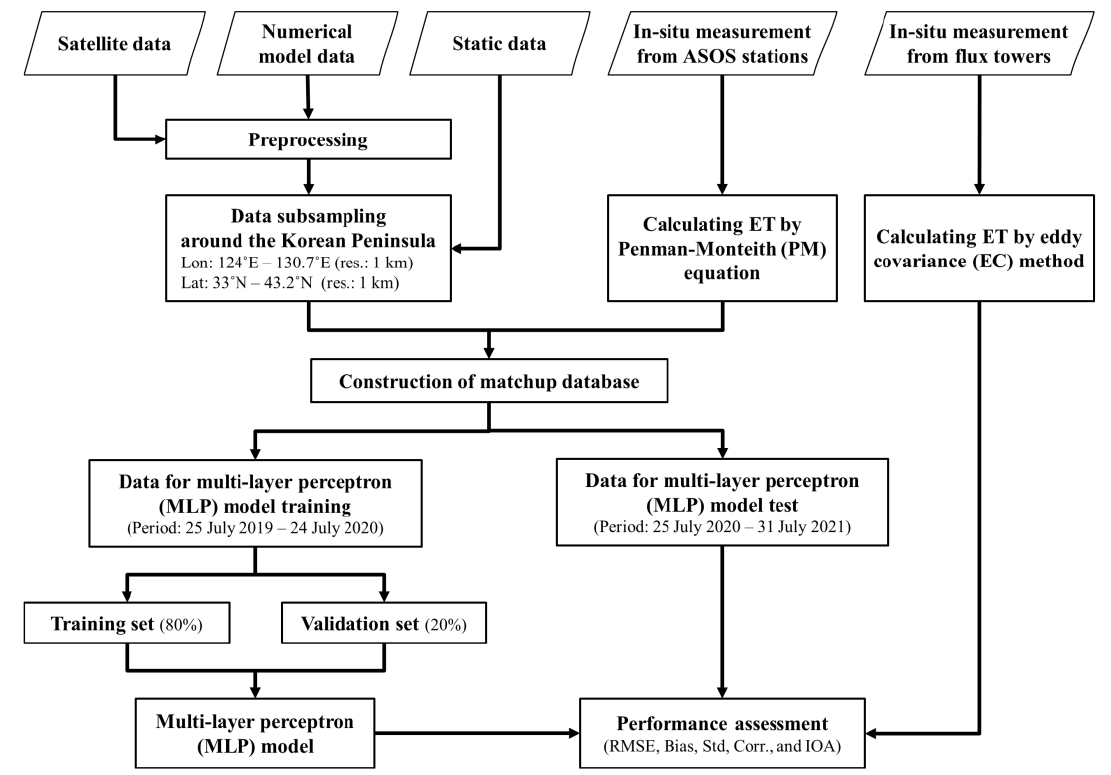
Figure 3. Flowchart illustrating the construction and assessment of the evapotranspiration (ET) retrieval artificial neural network (ANN) model.